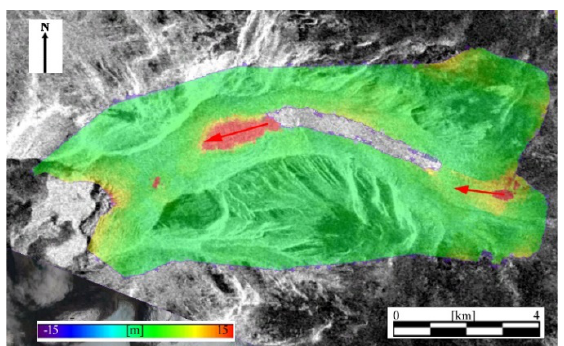
Figure 6. Amalia glacier displacement map.